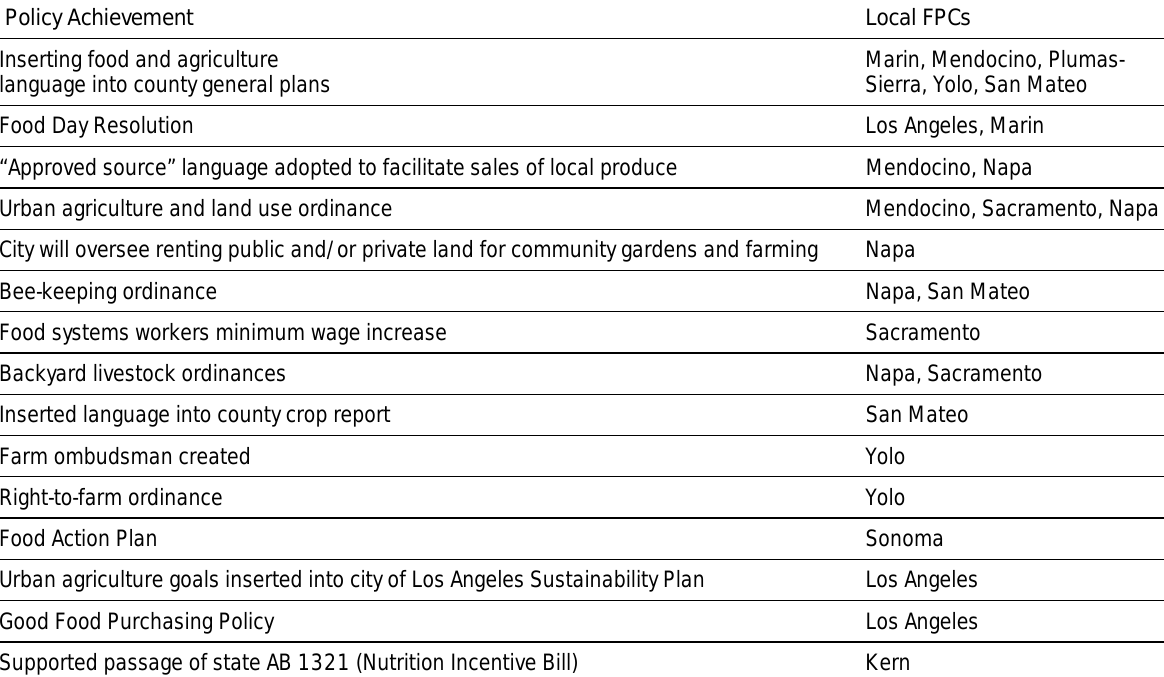
Table 2. Selected Examples of Policy Achievements Cited by FPC